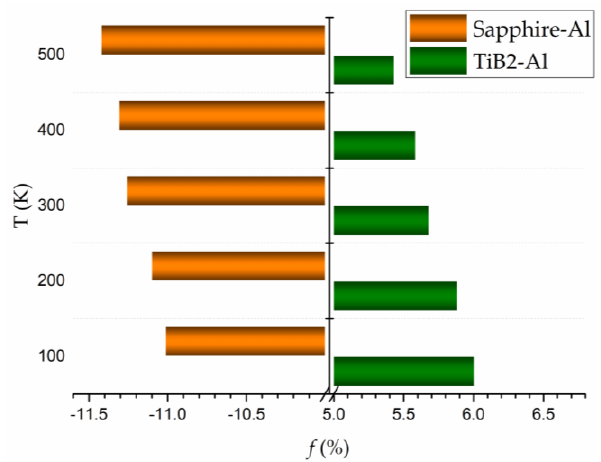
Figure 7. Temperature influence on the mismatches of the (0001) sapphire– (111) Al and the (0001) TiB 2 – (111) Al interfaces.